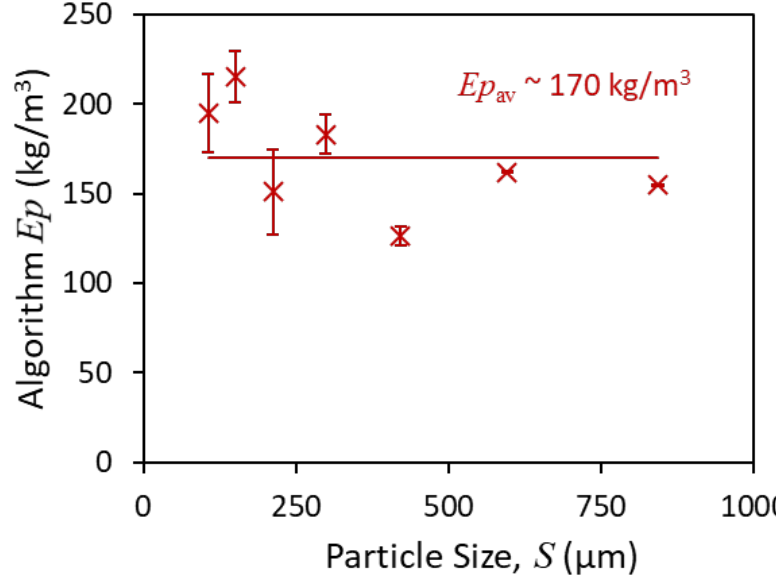
Figure 7. Variation in Ep as a function of particle size based on applying the algorithm to the LST flow fractionation data. There is some scatter with no observable trend, but the Ep is on average 170 kg / m 3 . RC separation z = 3 mm; RC flow fractionation z = 3 mm.